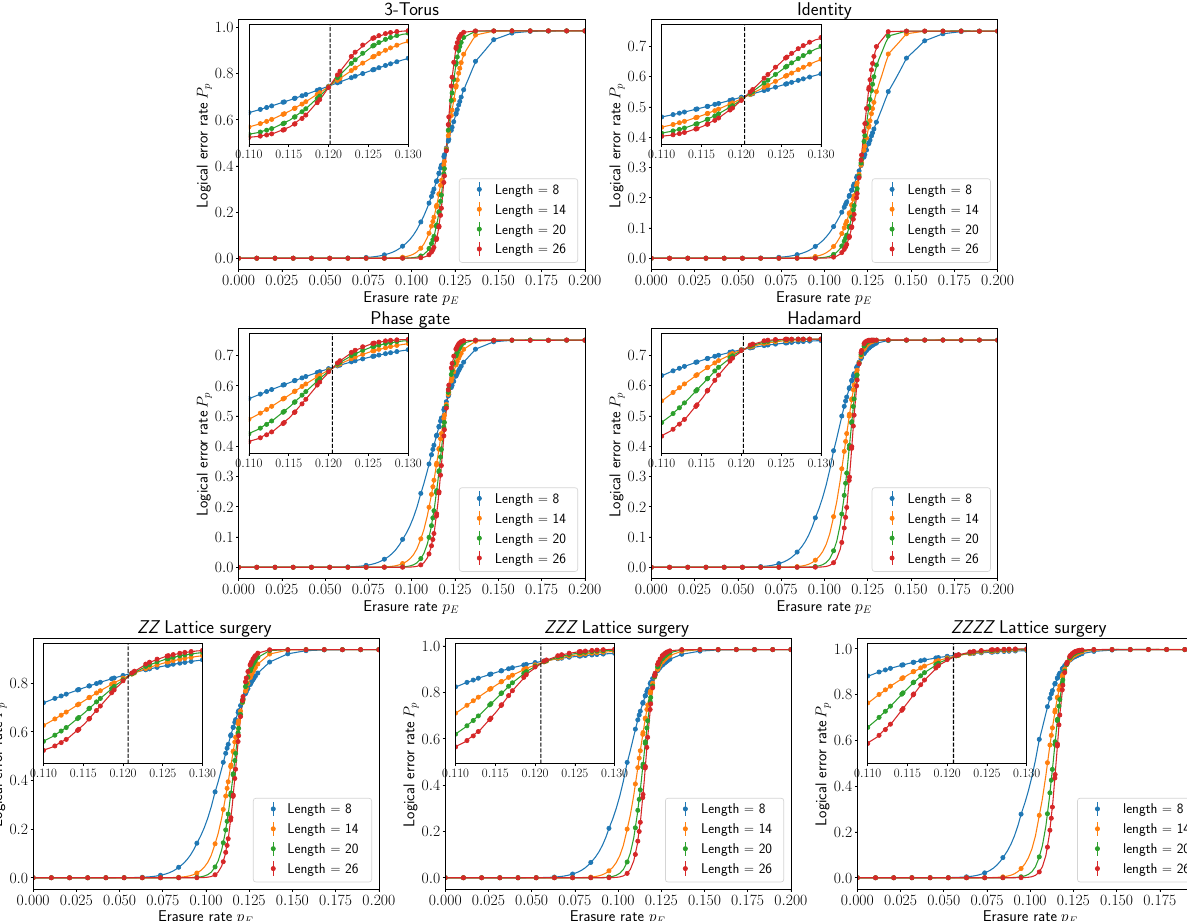
FIG. 25. Threshold crossing plots for the different logical blocks against IID erasure noise. The logical error rate is defined with respect to any logical error (which is block dependent). In other words, a logical error occurs whenever any of the logical membranes is incorrectly recovered. Each data point is the estimated logical error rate from 10 7 to 10 8 trials. The estimated thresholds are displayed with dashed